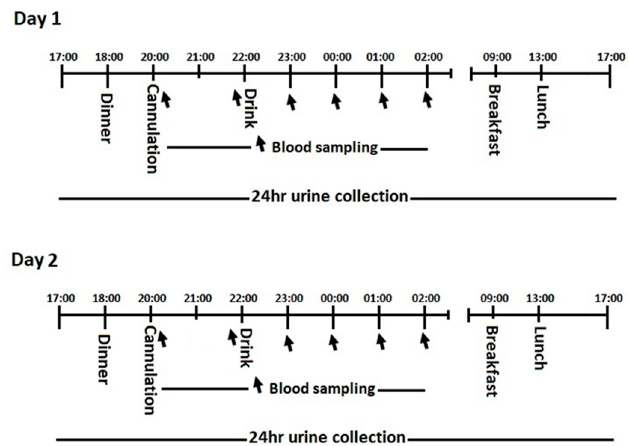
Figure 2. Experimental protocol.